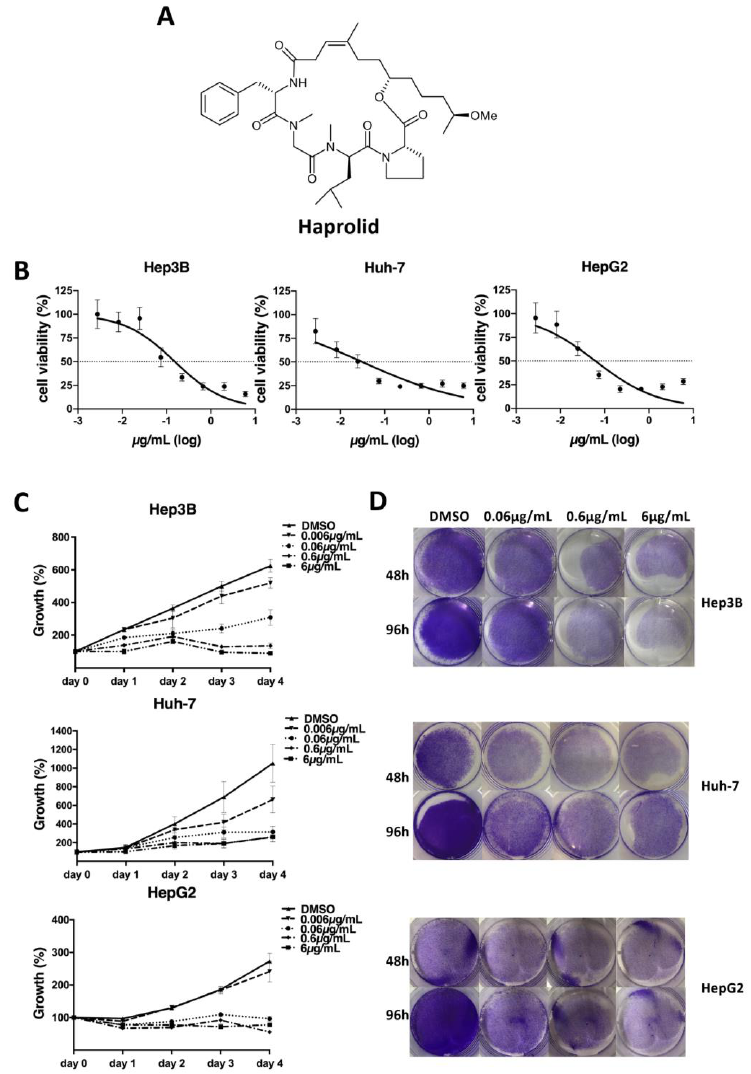
Figure 1. Haprolid treatment inhibits proliferation of human hepatocellular carcinoma (HCC) cells. ( A ) Chemical structure of haprolid. ( B ) Cytotoxic effect of haprolid (IC50): Hep3B, Huh-7 and HepG2 cells were treated for 96 h with increasing concentrations of haprolid (0.001 to 18 µg/mL). WST-1 assay was performed to analyze cellular viability, DMSO was used as negative control. ( C ) Cell proliferation of HCC cells treated with the indicated concentrations of haprolid or DMSO measured by WST-1 assay. The relative cell number was normalized with the control. ( D ) HCC cells were fixed and stained with crystal violet 48 and 96 h after haprolid treatment. Data represent means ± SEM of at least three independent experiments. * p < 0.05, ** p < 0.01, *** p < 0.001, **** p < 0.0001.